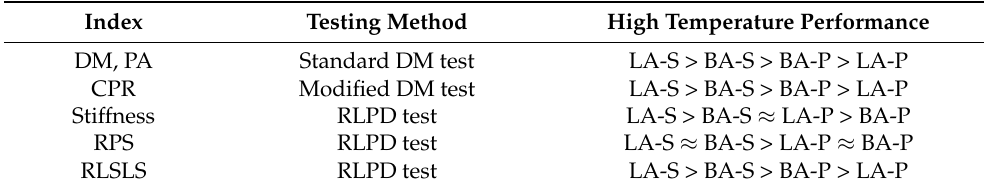
Table 9. The order of different indices according to high-temperature